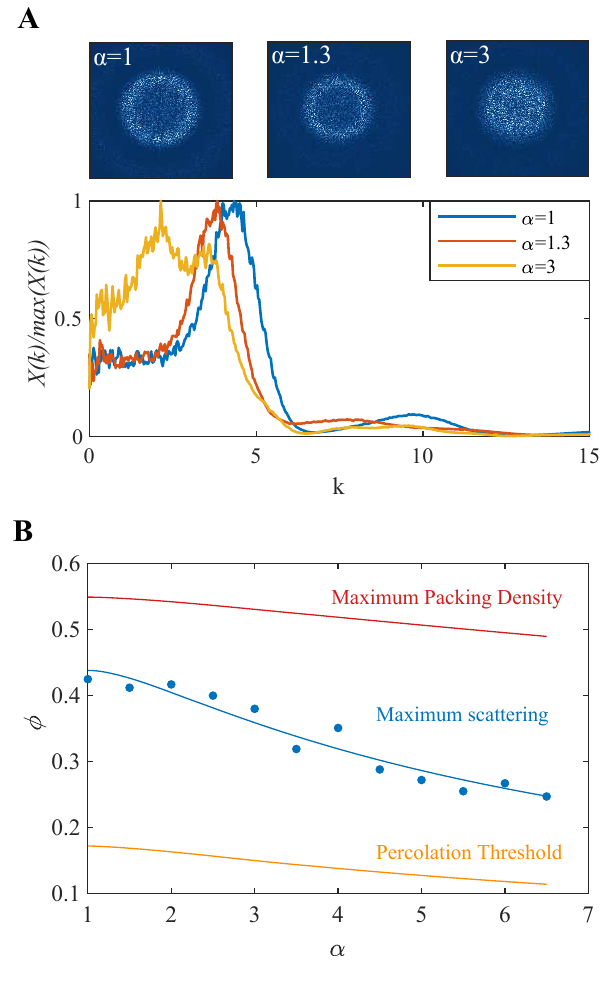
Figure 3: Two-phase heterogeneous analysis: (A) spectral density images for α (cid:2) 1 , 1 . 3 , 3 at ϕ radial average plot and (B) density plot as a function of the aspect ratio, showing three curves fi tted using the excluded are principle given by Eq. (1): (i) percolation threshold curve (yellow) fi tted with c 1 (cid:2) 2 / π and c 2 (cid:2) ( 2 + 8 / π ) where ensembles below exhibit weak correlation; (ii) maximum scattering density curve (blue) fi tted with c 1 (cid:2) 0 . 3780 and c 2 (cid:2) 1 . 5255 represents the ensembles at which the zeroth wavevector spectral density function χ maximum; and (iii) the maximum packing density curve (red) fi tted with c 1 (cid:2) 0 . 047 and c 2 (cid:2) 1 .